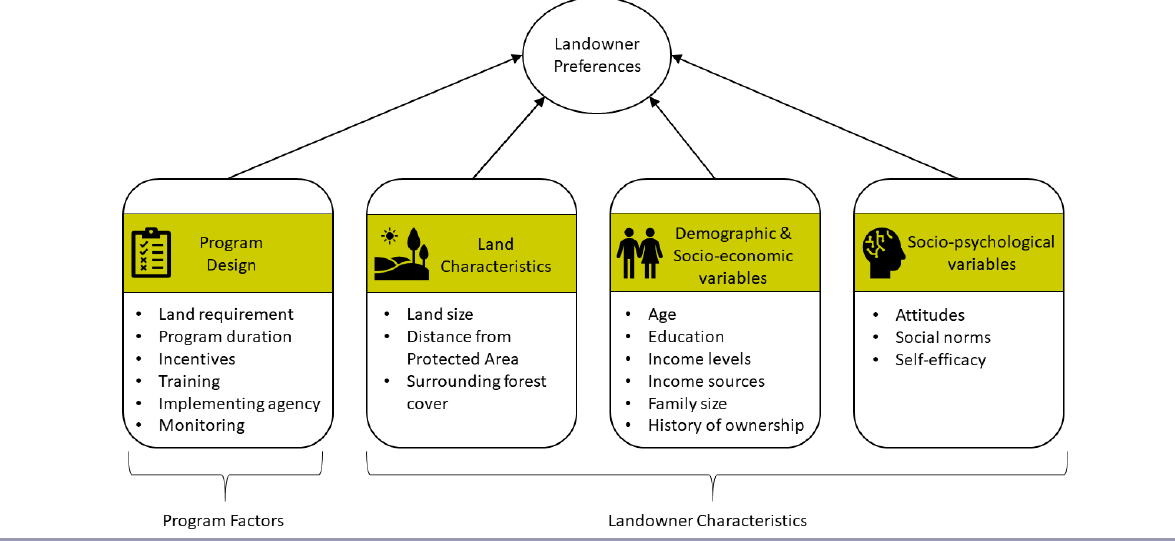
Fig. 1. A theoretical framework classifying “program factors” and “farmer (landowner) characteristics.” The latter include land characteristics, demographic, economic, and socio- psychological variables that can influence landowner preferences or willingness to participate in an incentive-based conservation program. Note: this is not an exhaustive list of variables, but a representative subset, some of which have been used in our